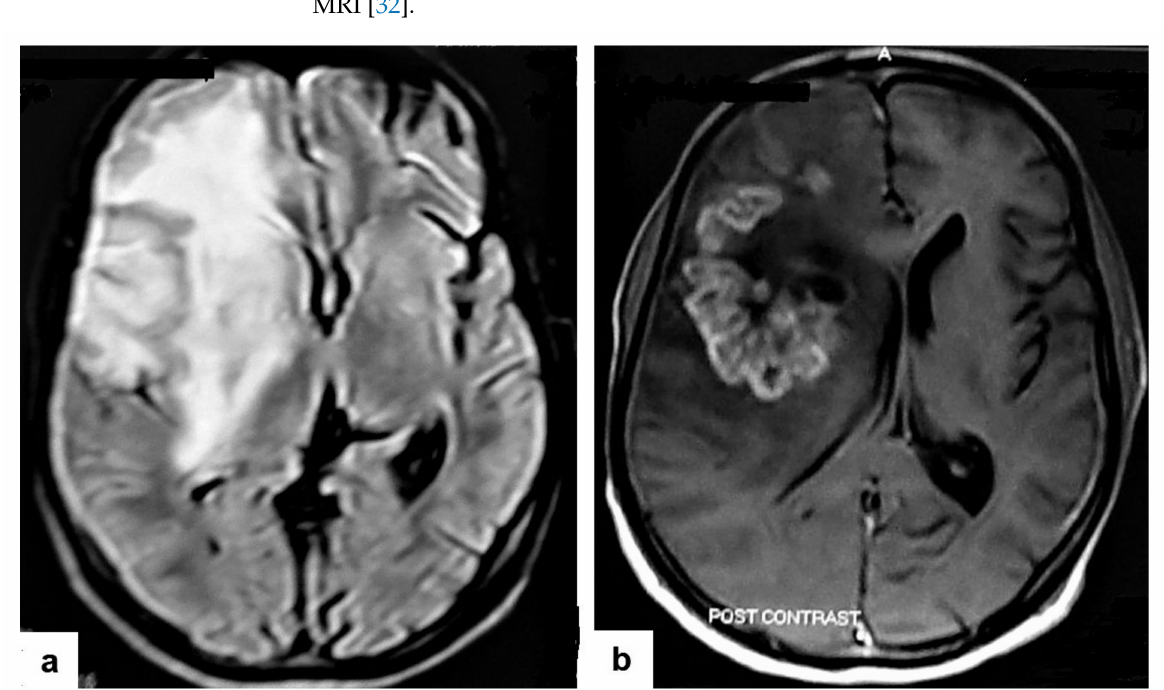
Figure 14. Tuberculous cerebritis in an adult man with fever and seizures. ( a ) Axial FLAIR-weighted images of brain MRI show high signal intensity in the right parietal and frontal lobes causing mass effect compressing the right lateral ventricle with mild shifting of the midline to the contralateral side. ( b ) Axial brain T1-weighted images post-contrast administration show intense serpentine (gyriform) enhancement in the right parietal and frontal lobes, with significant surrounding edema, suggesting tuberculous